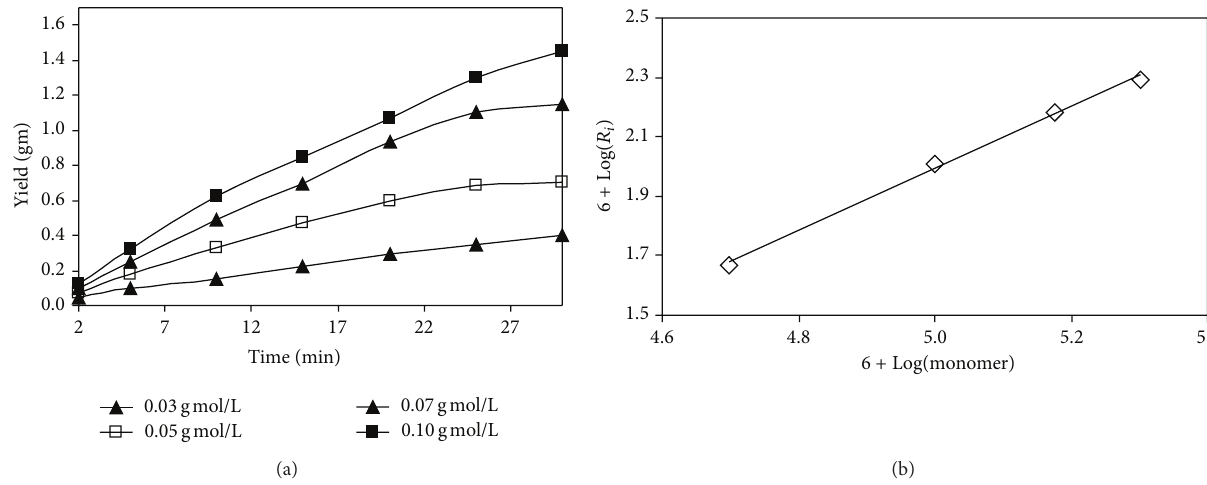
Figure6:(a)Conversion-monomer/molconcentrationeffectontheaqueousoxidativepolymerizationof(POPDA)atdifferenttimeintervals. (b) Double logarithmic plot of the initial rate and monomer concentration of POPDA.